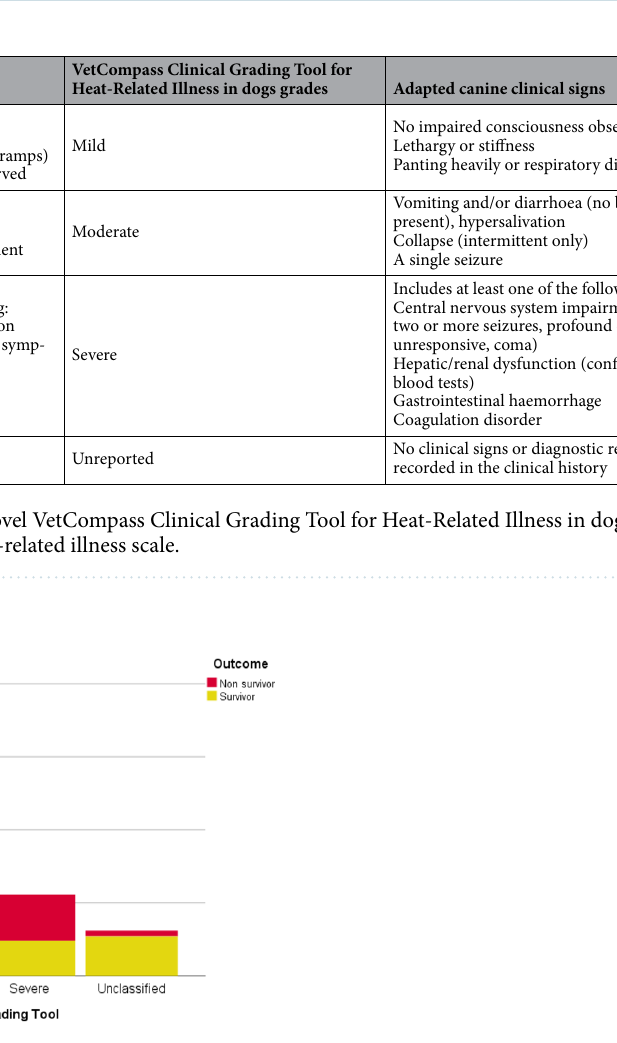
Figure 2. The event distribution and survival outcomes for HRI grades defined using the VetCompass Clinical Grading Tool for Heat-Related Illness in dogs presenting to primary-care veterinary practices in the UK between 2016 and